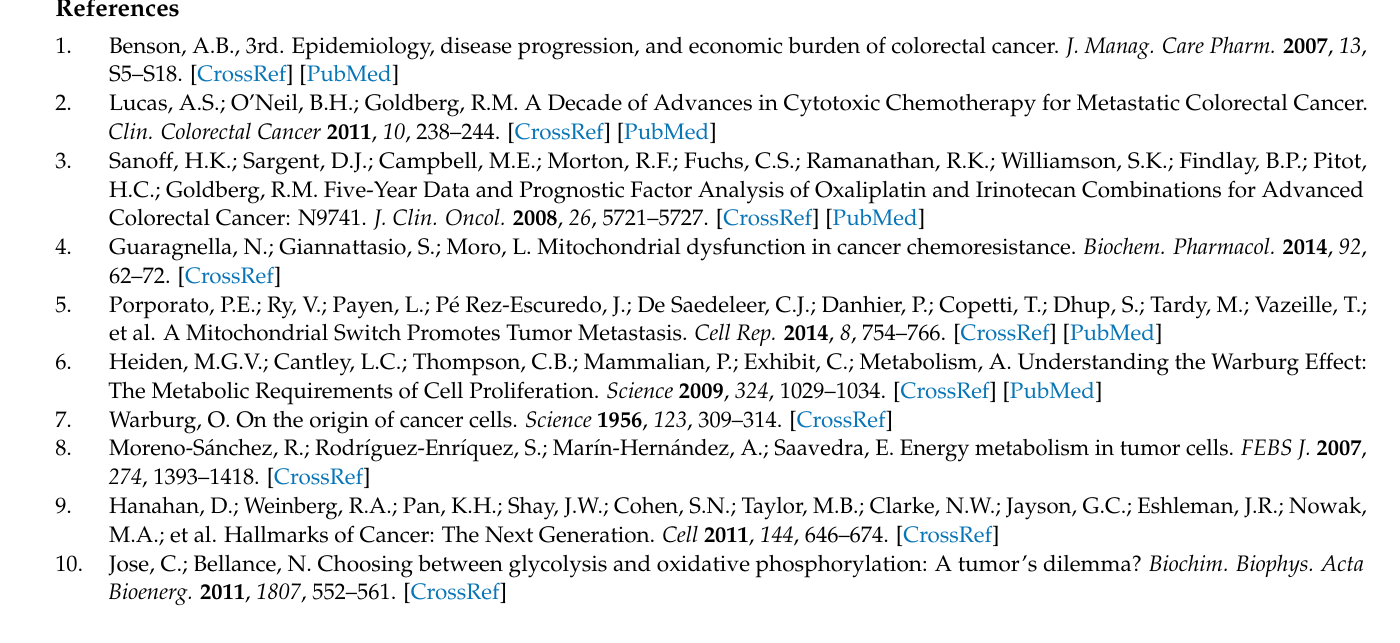
blot analysis, Figure S2: Comparison between a primary cancer cell line (HT29) and a metastatic cancer cell line (SW620), Figure S3: Data analysis from public gene expression databases, Method S1: Loading controls for Western Blot analysis, Method S2: Cell culture, RT-qPCR, and Western